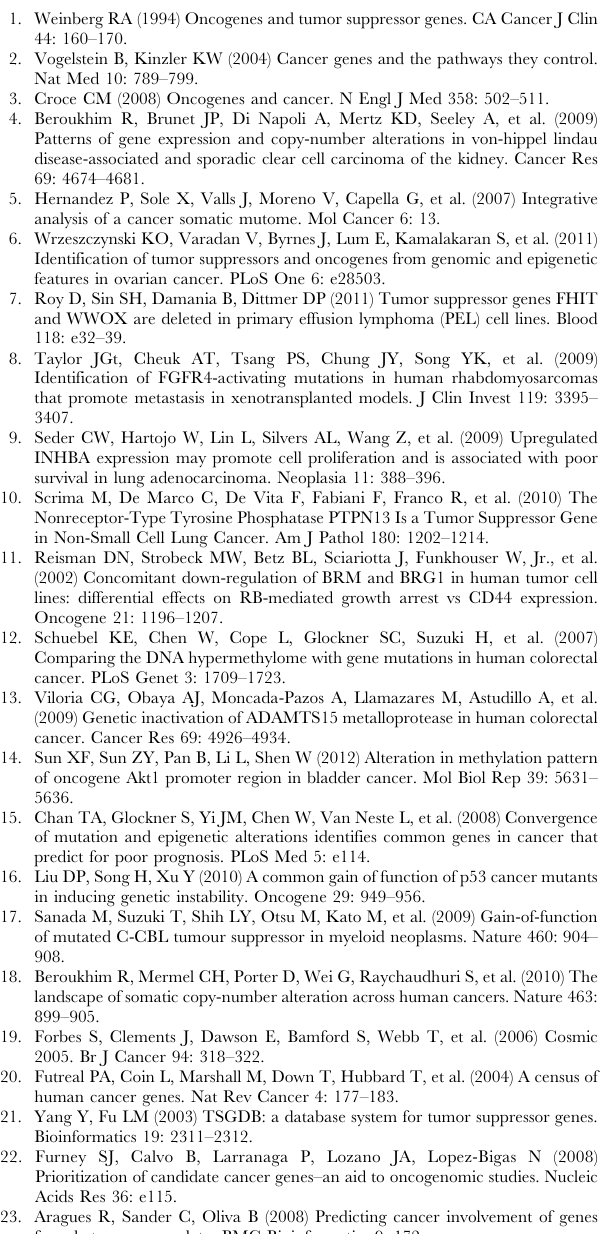
Table S8 Expression, methylation and copy number datasets used in this